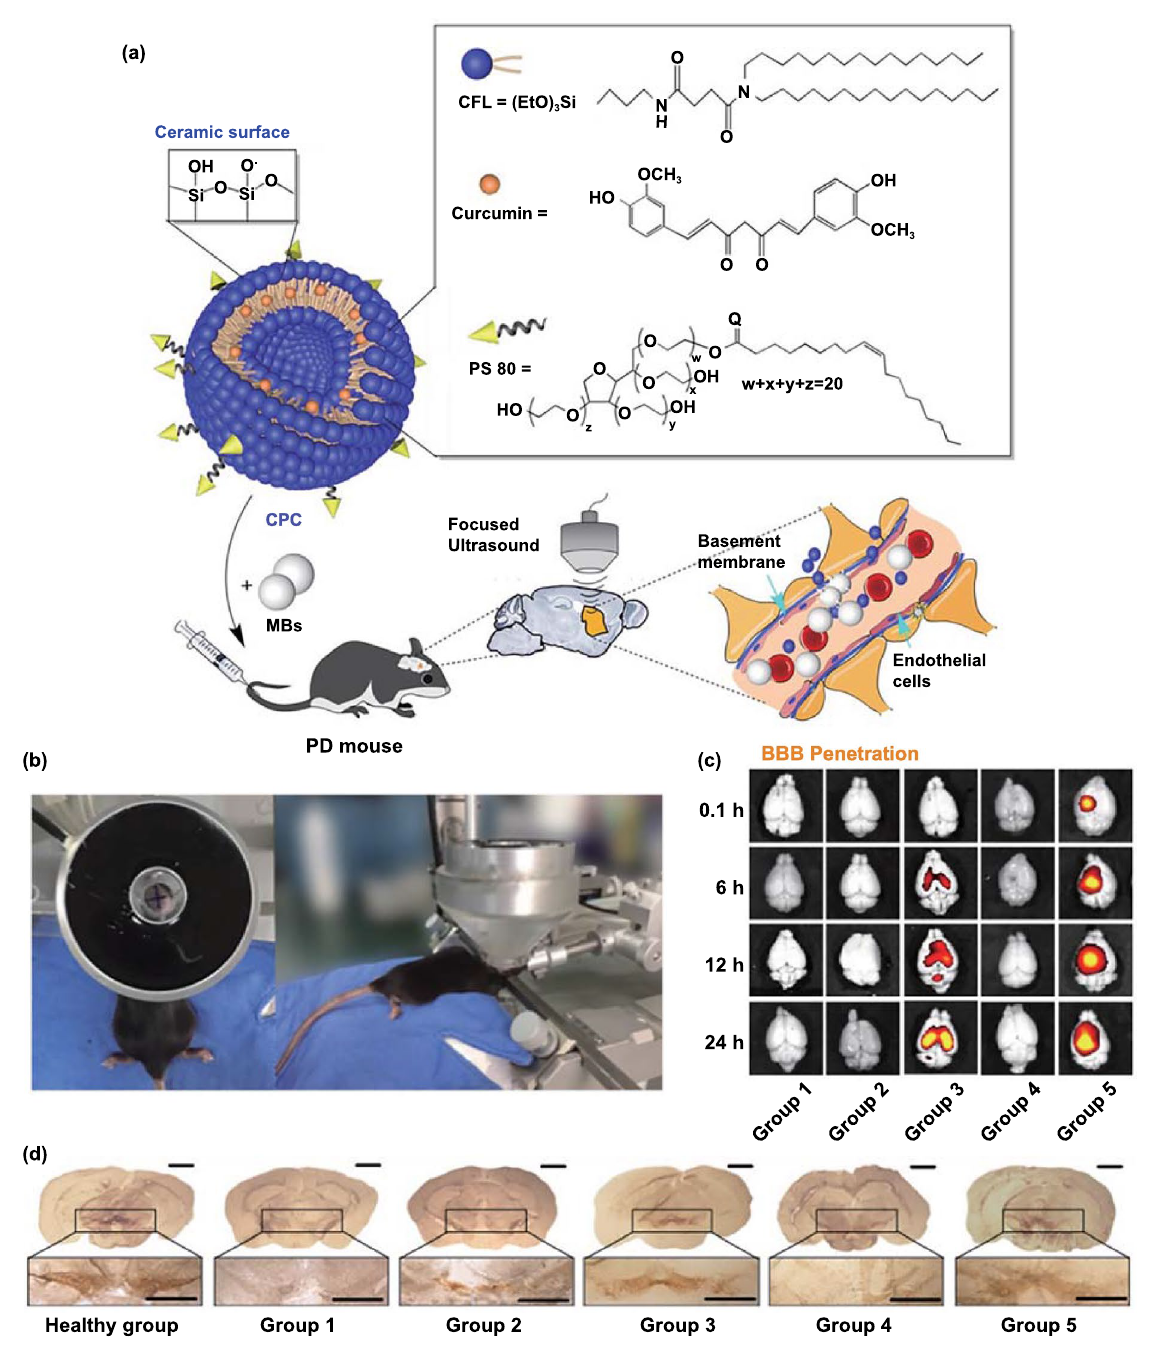
Fig. 9 Example of focused ultrasound-mediated brain delivery for PD treatment. a Improvements in the therapeutic efficacy of curcumin in PD mouse models obtained using CPC combined with ultrasound-targeted microbubble destruction. Schematic of the chemical composition of CPC and the non-invasive localized delivery of CPC NPs to the mouse brain via the ultrasound-targeted microbubble destruction technique for PD therapy. b Photograph of the ultrasound-targeted microbubble destruction setup for the local treatment of the corpus striatum in C57BL/6 mice. c Representative ex vivo fluorescence images obtained at 0.1, 6, 12, and 24 h after intravenous administration ( n = 6 per group at each time point). d Representative immunohistochemical staining images of TH + neurons in the SN in mouse brain sections from different groups ( n = 6 per group). Group 1: control; Group 2: only curcumin-loaded cerasomes with no PS 80; Group 3: only CPC with 5% PS 80; Group 4: 5% PS 80-modified cerasomes with no curcumin in combination with ultrasound-targeted microbubble destruction; Group 5: CPC with 5% PS 80 in combination with ultrasound-targeted microbubble destruction. Adapted with permission from Ref.